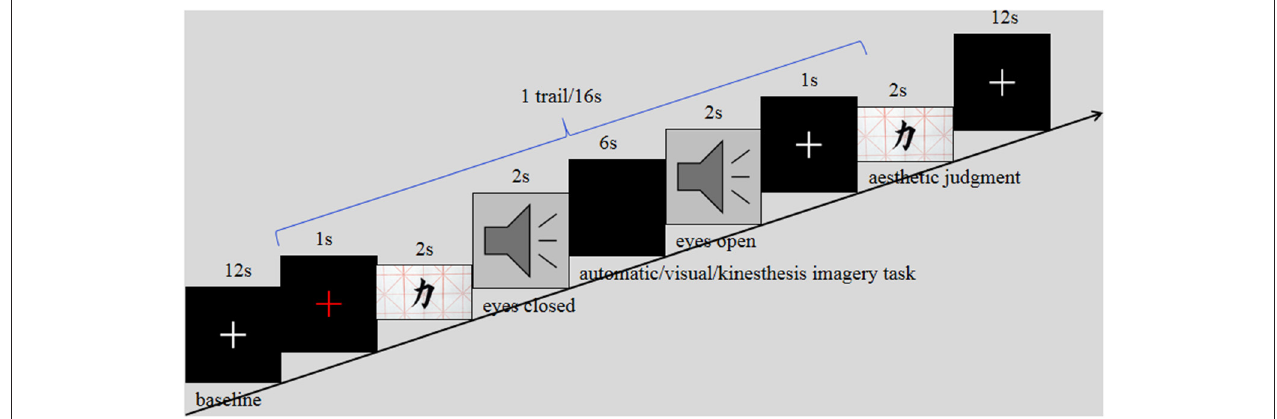
FIGURE 1 | Experimental design, procedure, and examples of stimuli. Three types of tasks were performed in separate runs, namely, kinesthetic, visual, and automatic imagery (aesthetic